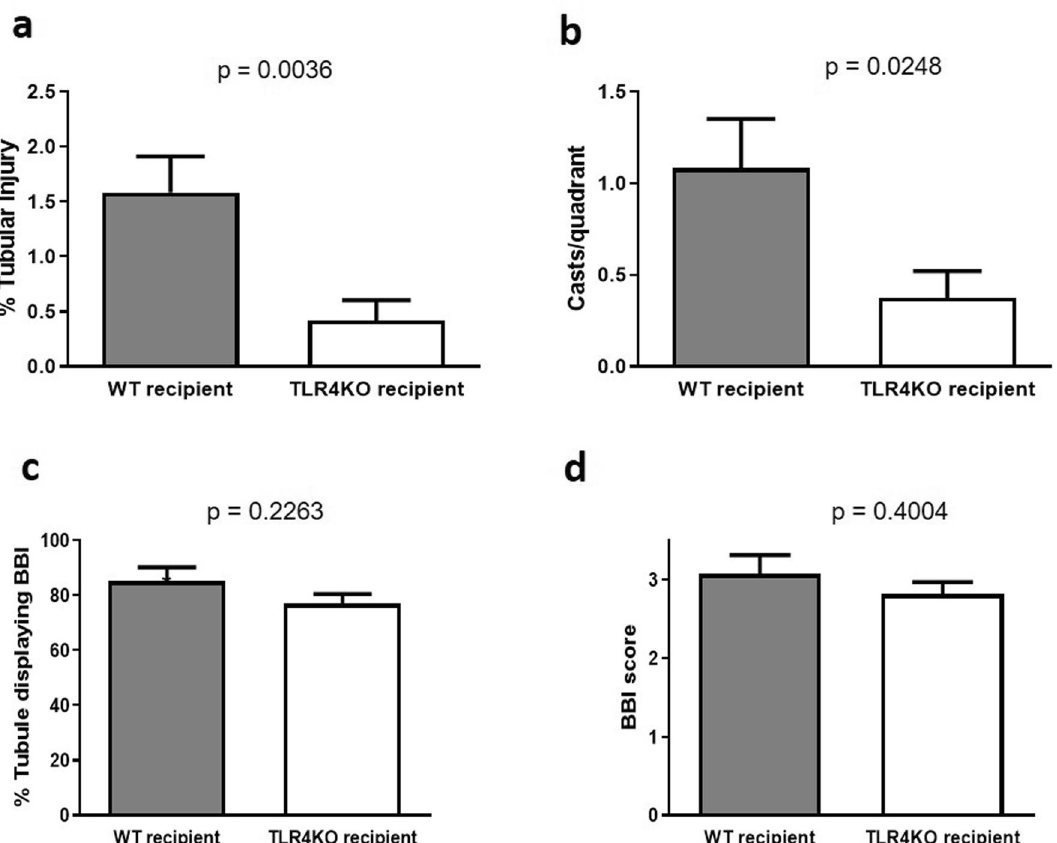
Figure 5. Assessment of brush border injury and its severity: ( a , b ) Tubular injury (1.583 ± 0.329 vs. 0.416 ± 0.189) and cast formation (1.083 ± 0.268 vs. 0.375 ± 0.145) were significantly reduced in kidneys transplanted from TLR4 knockout donors compared to kidneys transplanted from wild type donors (** p < 0.01 vs. TLR4KO-WT for tubular injury and * p < 0.05 vs. TLR4KO-WT for cast formation). ( c , d ) The percent of tubules displaying Brush-border injury (85.25 ± 5.0 vs. 76.98 ± 3.55) and its severity (3.075 ± 0.237 vs. 2.820 ± 0.151) based on the percent of the circumference of the tubule displaying BBI (please see “Methods” section) both did not change significantly in transplanted wild type and TLR4 knockout kidneys ( p = ns), ns not significant. Data were analyzed using an unpaired two-tailed Student t test. Values are means ± SEM. n per group = 7. WT–WT represents kidney transplanted from wild type donor to wild type recipient and TLR4KO-WT represents kidney transplanted from TLR4 knockout donor to wild type